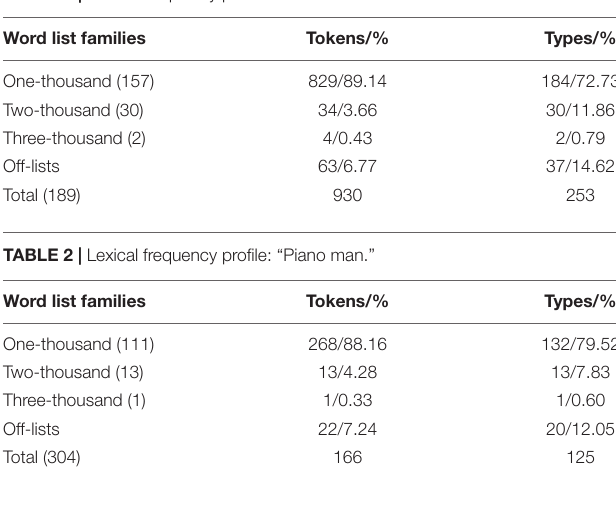
TABLE 1 | Lexical frequency profile: “Have it all.”